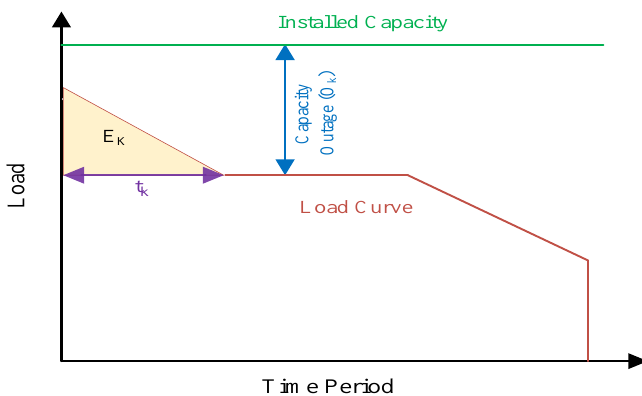
Figure 2. Evaluation of loss of load expectation (LOLE) and loss of energy expectation (LOEE) using an hourly load curve.